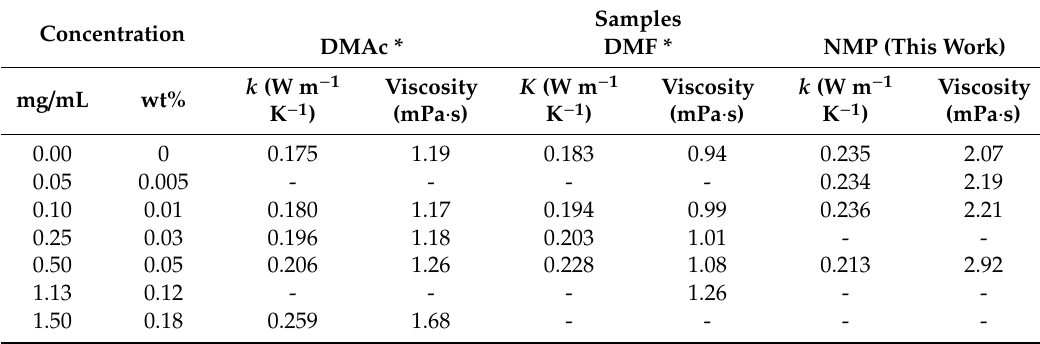
Table 1. Thermal conductivity and viscosity of graphene based nanofluids. Samples Concentration DMAc * DMF * NMP (This Work) mg /